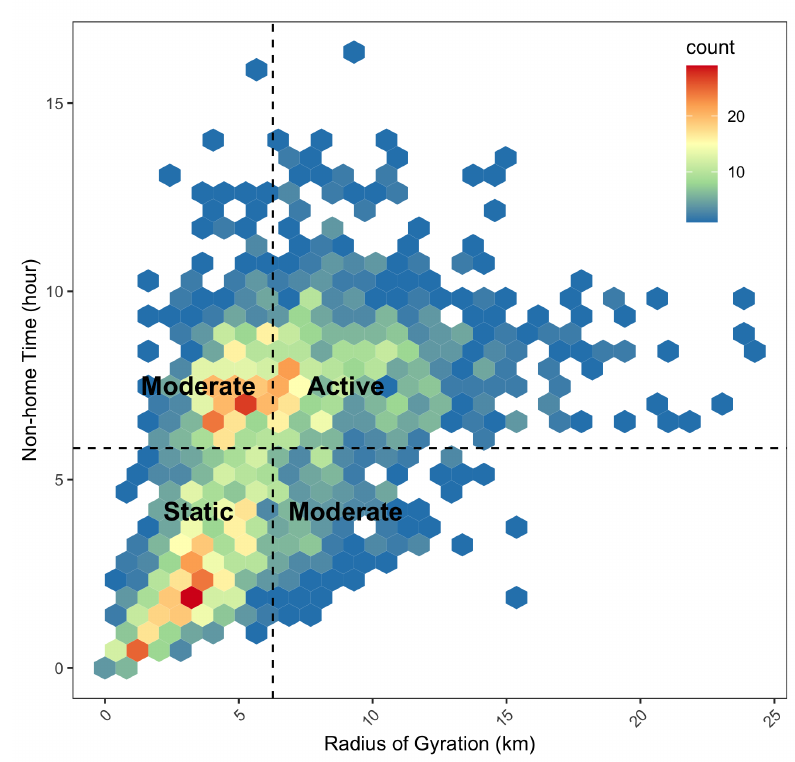
Figure 1. Stratification of individuals’ travel patterns based on the averaged travel distance (RoG) of 6.27 km and time spent away from home (Non-home time) of 5.84